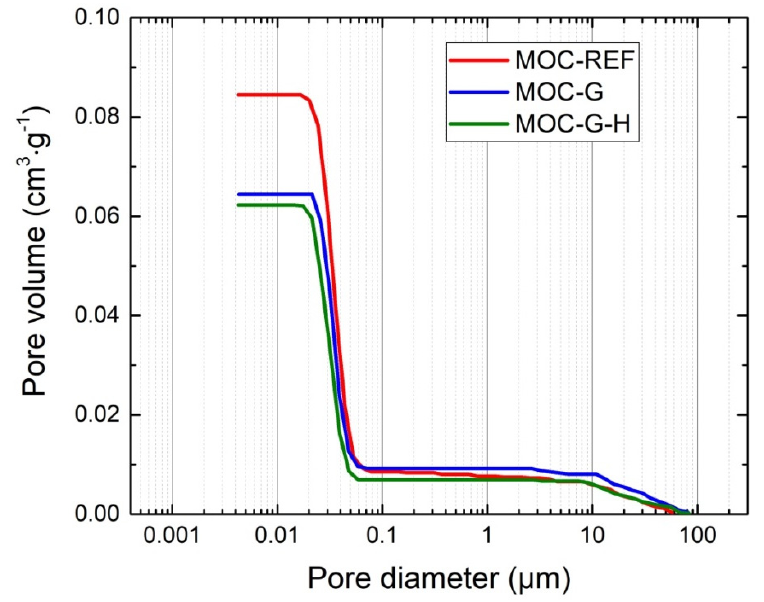
Figure 10. Cumulative pore volume distribution for 14-day composites.